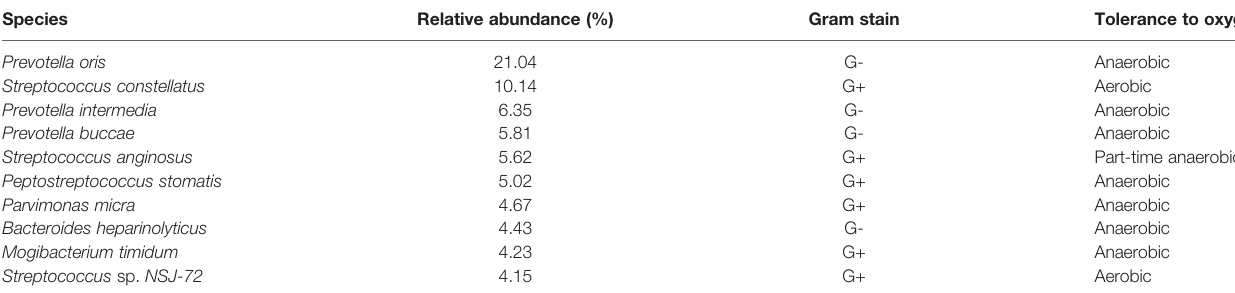
TABLE 2 | Top 10 species detected in DNM